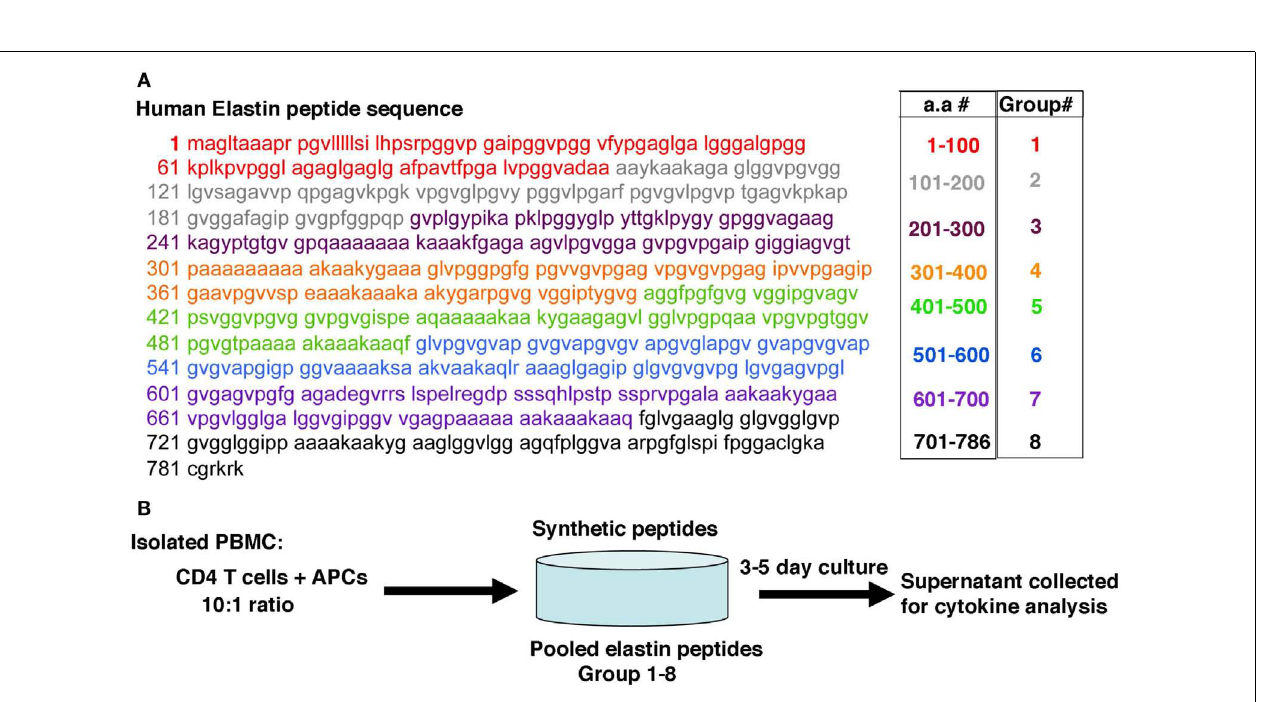
into 8 pools. (B) Each pooled groups were added to CD4 + T cell (5 × 10 5 ) and CD1a + APCs (5 × 10 4 ) for 3–5days. Supernatant were collected and stored at − 80 for batch analysis of selected cytokines using LINCOplex